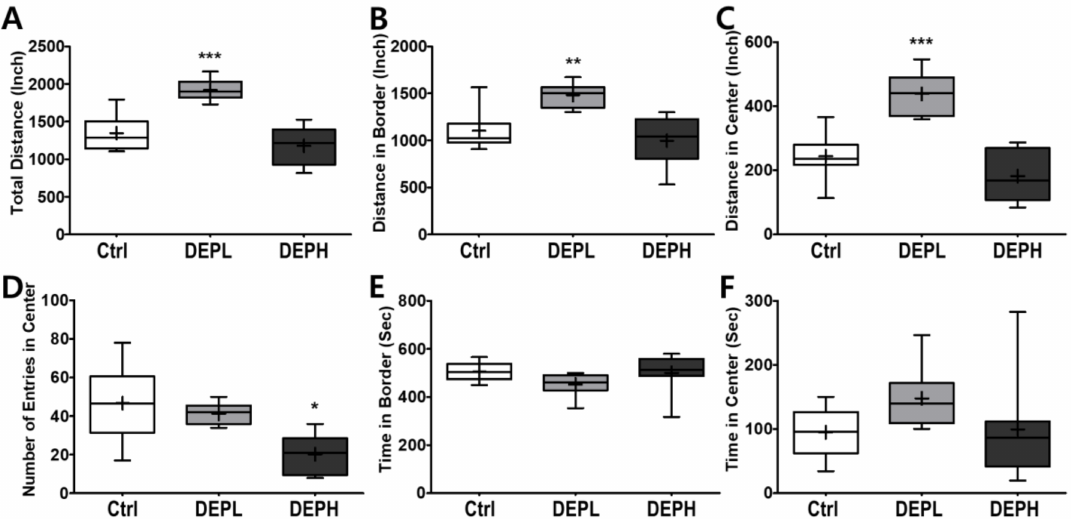
Figure 7. Box-and-whisker plots presenting behavior changes in the open-field after diesel exhaust particles (DEP) exposure. ( A ) The total distance the mice traveled, ( B ) distance traveled in the border area, ( C ) distance traveled in the central area, ( D ) number of entries into the center, ( E ) time spent in the border area, and ( F ) time spent in the center area during the 10 min of the open field test; n = 8 for each group. The one-way ANOVA was followed by Tukey’s post-hoc test; * p < 0.05; ** p < 0.01; *** p < 0.001.